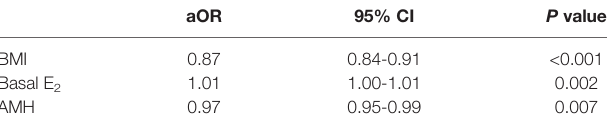
TABLE 2 | Variables associated with the functional ovarian cyst formation in arti fi cial frozen-thawed embryo transfer cycles with GnRH agonist: multivariate logistic regression analysis.